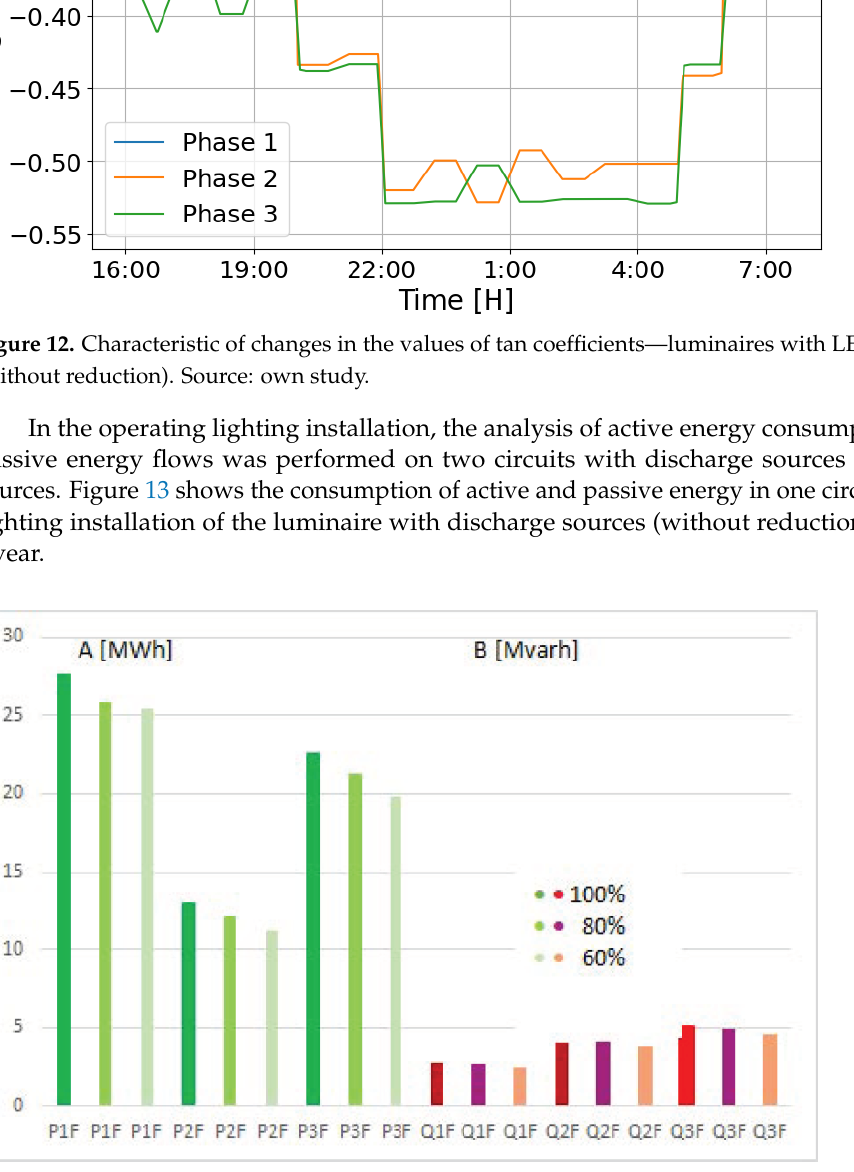
Figure 13. Active and passive energy consumption in 1 circuit of the lighting installation of the lumi- naire with discharge sources (no reduction—100%, with a reduction—80%, with a reduction—60%). Source: own